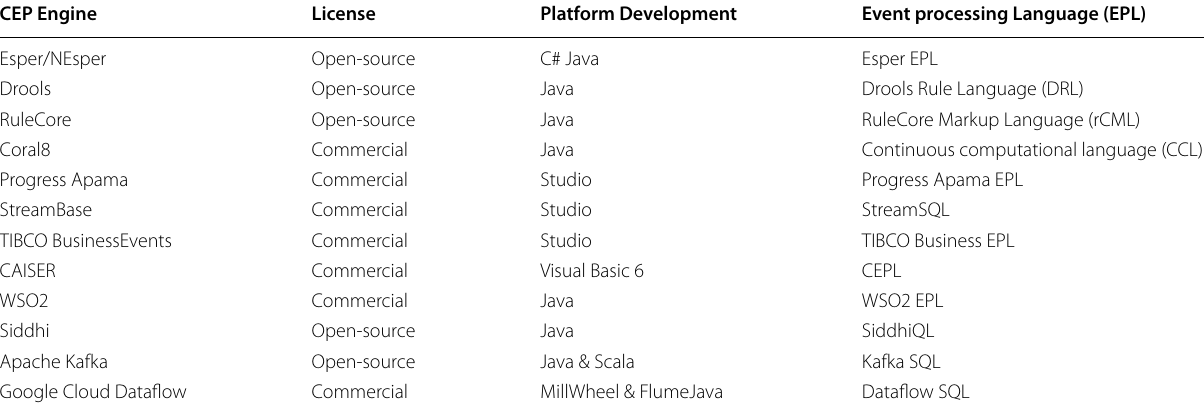
Table 4 Example of available CEP